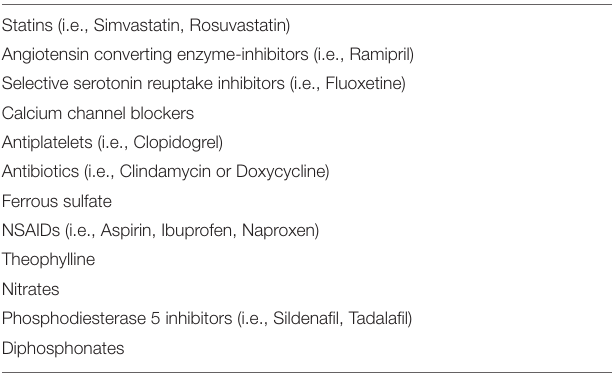
TABLE 1 | Drugs commonly associated with esophageal damage and/or onset of reflux-like symptoms.